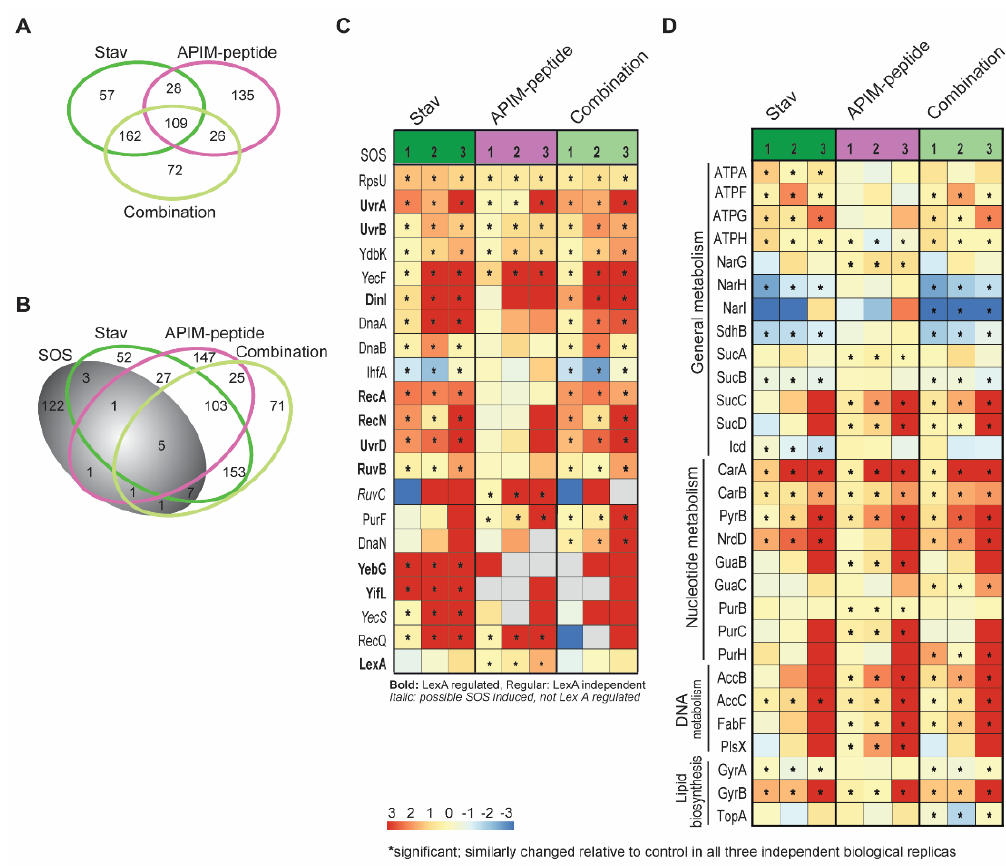
Figure 4. Stavudine induces SOS in Escherichia coli . Results of the MIB assay of extract from E. coli MG1655 treated with stavudine (Stav, 0.32 μ g/mL), APIM-peptide (26 μ g/mL) and the combination (Stav + APIM-peptide) for 2 h. Data from three independent biological replicas are shown. Protein concentrations are given as log 2 fold change relative to untreated control. ( A ) Venn diagrams displaying the number of proteins significantly changed in pull-downs from treated cells relative to untreated control according to the Wilcoxon signed-rank test. ( B ) Venn diagram showing an overlap in the different treatment groups with proteins involved in SOS [53]. ( C ) Heatmaps displaying log 2 fold change in protein concentration of SOS proteins relative to untreated control in the different treatment groups. The grey boxes represent no data. ( D ) Heatmaps displaying log 2 fold change in proteins concentration of proteins involved in general metabolism, nucleotide metabolism, lipid biosynthesis and DNA metabolism relative to untreated control in the different treatment groups. * Proteins that are significantly changed according to the Wilcoxon signed-rank test (i.e., changed the same way in all three